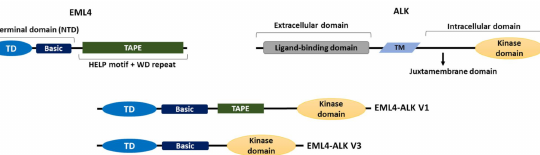
Figure 1. The domain organizations of EML4, ALK and EML4-ALK V1 and V3. A cartoon illustrat- ing the domain organizations of EML4, ALK and the two most commonly occurring EML4-ALK variants, the long V1 (E13; A20) and the short V3 (E6; A20); “E” and “A” represent the exons of EML4 and ALK, respectively, that are fused in each variant. Both variants contain the intracellular kinase domain of ALK and the TD and basic region of EML4. V1 also expresses a truncated TAPE domain from EML4 whereas V3 completely lacks the TAPE domain. TM = transmembrane domain, TD = trimerization